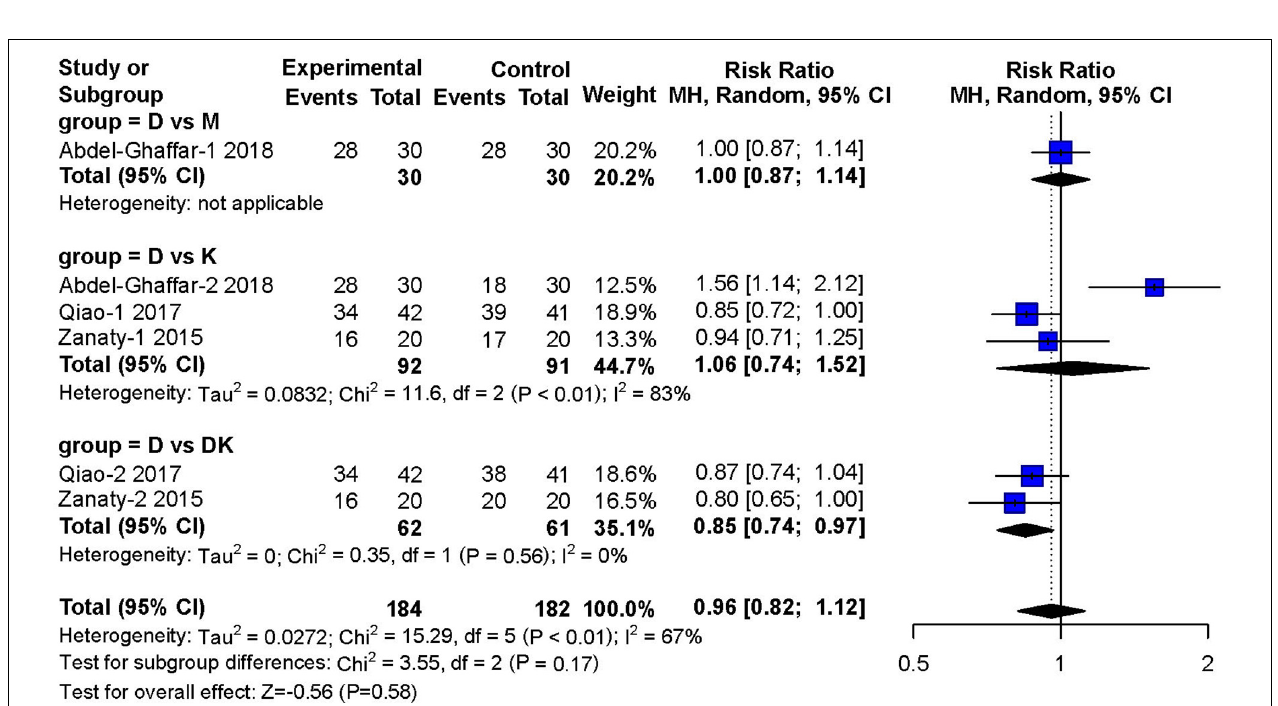
FIGURE 5 | Meta-analysis of nebulized dexmedetomidine for sedation satisfaction in diagnostic procedures and elective operations.CI, confidence interval; df, degress of freedom; M-H, Mantel-Haenszel.